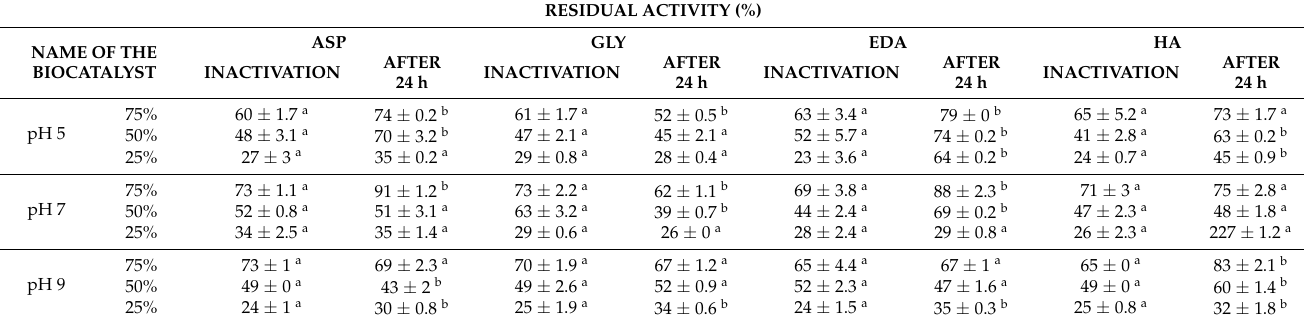
Table 4. Residual activity of different immobilized CALB biocatalysts in the inactivation courses at pH 5.0 and 80 ◦ C, pH 7.0 and 75 ◦ C and pH 9.0 and 60 ◦ C. The activities were taken during the inactivation and after 24 h of incubation at pH 7.0 and 25 ◦ C using pNPB as substrate. Means in the same line and blocking agent sharing the same letter (a or b) are not statistically different according to the Tukey test ( p >